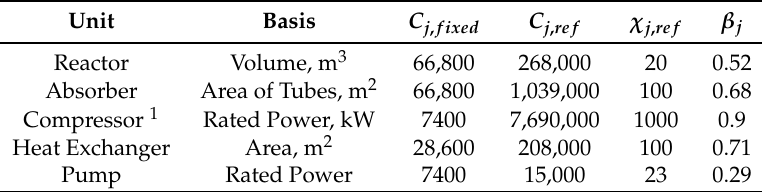
Table 8. Capital cost